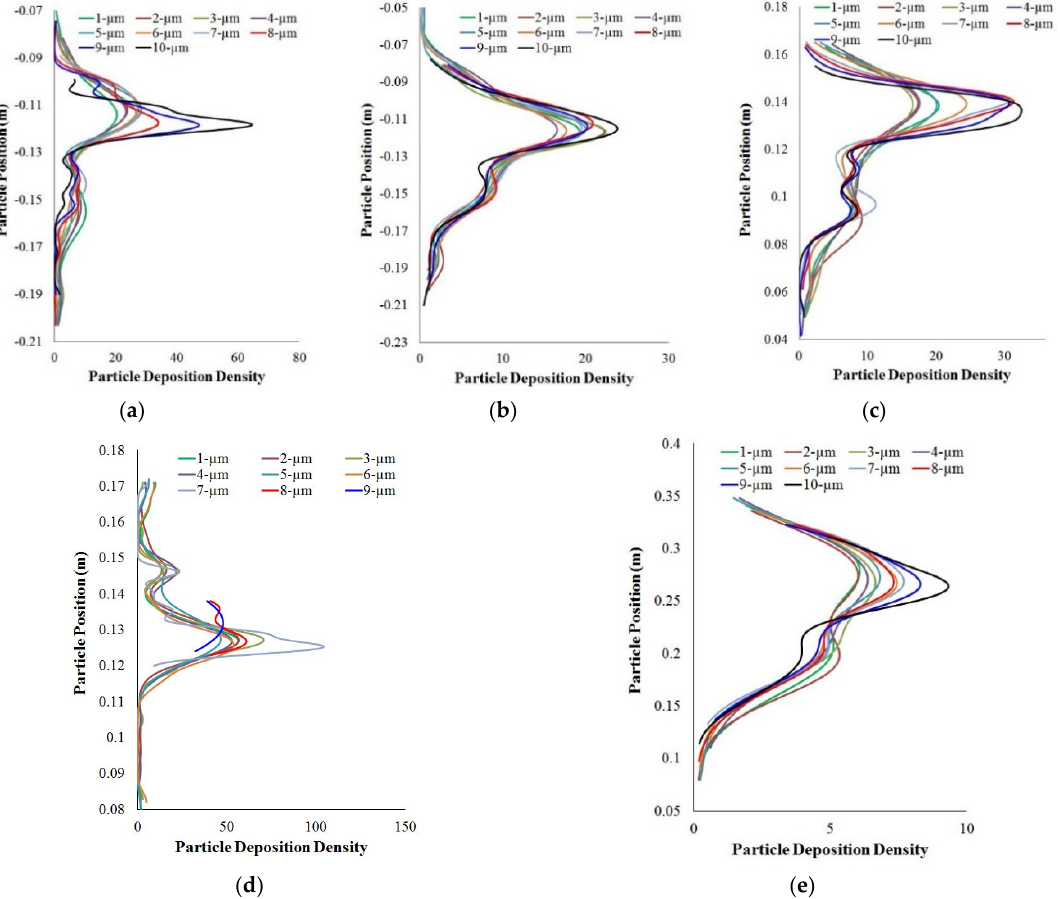
Figure 8. Particle deposition density comparison at different lobes of a 17-generation lung model. ( a ) right upper; ( b ) right middle; ( c ) right lower; ( d ) left upper; ( e ) left lower. Particle deposition density is the number of deposited particles and deposition concentration is calculated along the y-axis of the corresponding lobes [183].